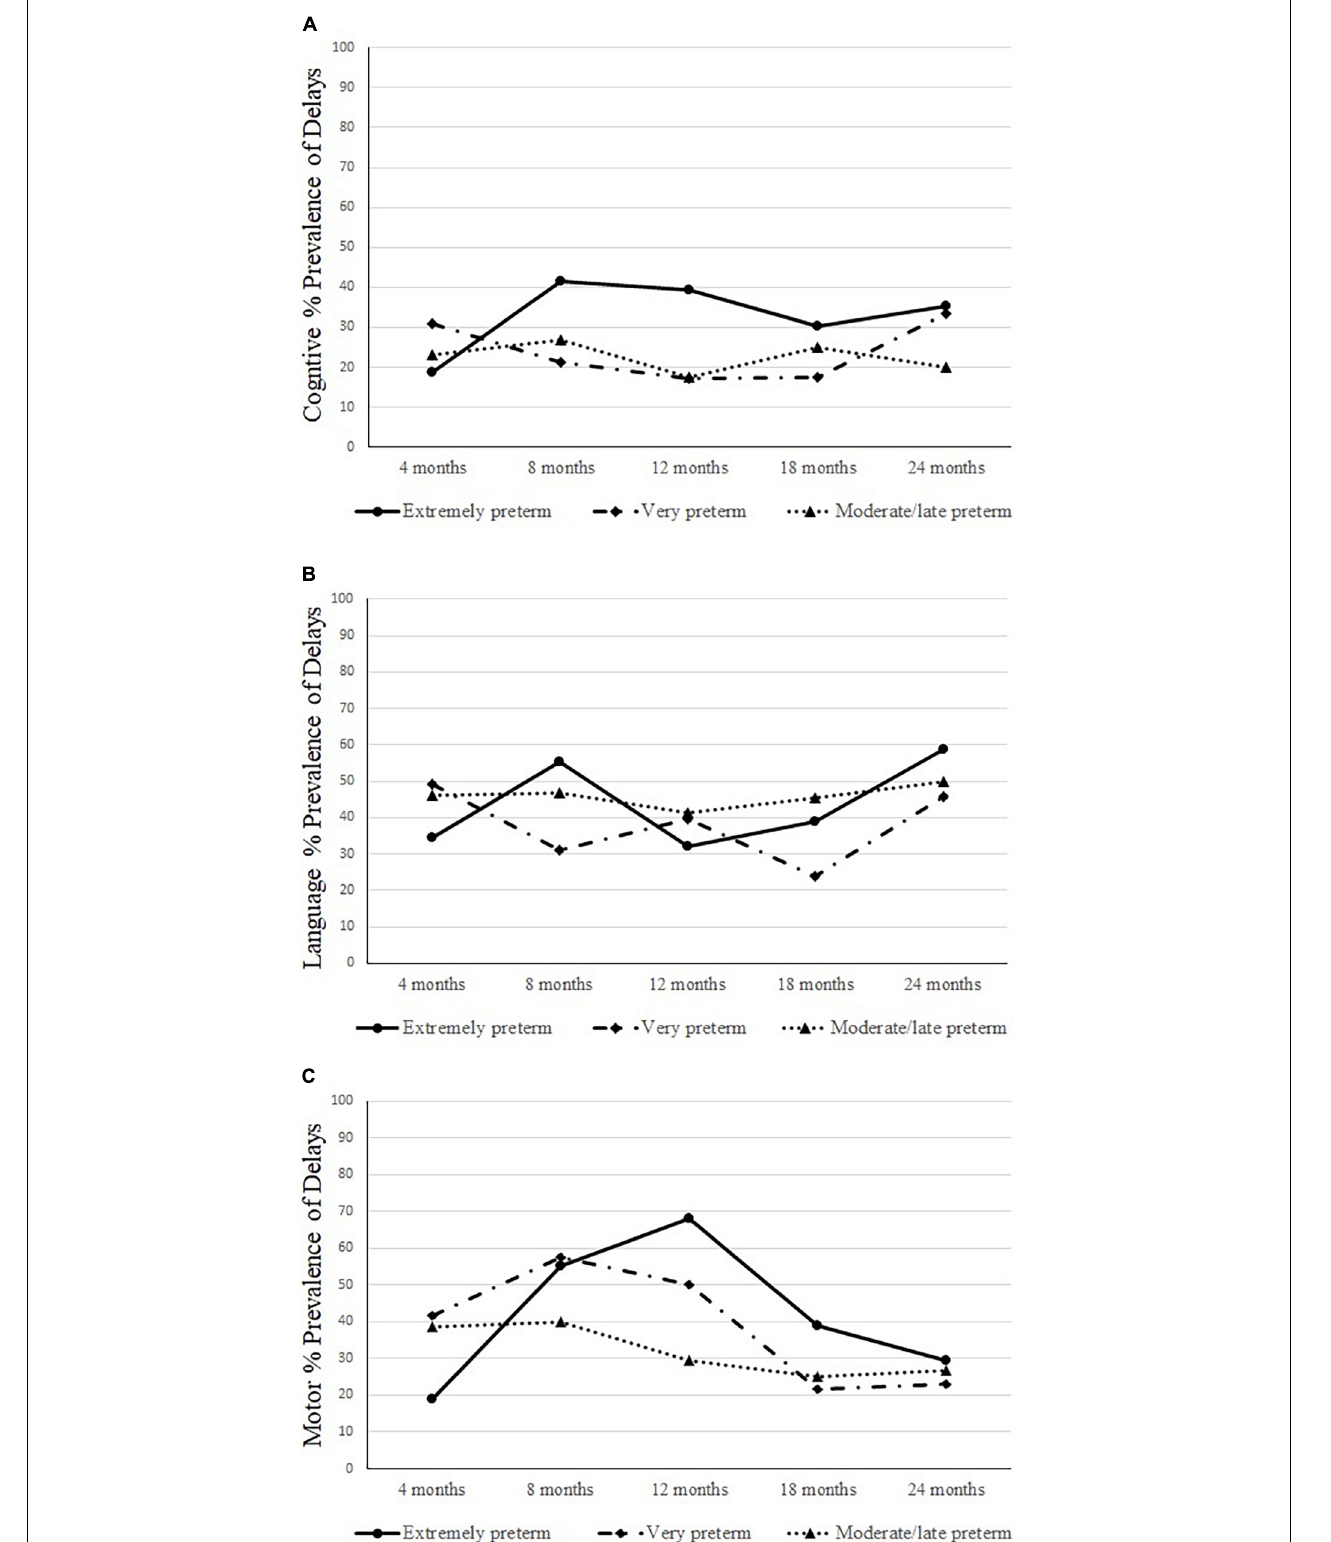
FIGURE 2 | Prevalence of cognitive (A) , language (B) , and motor (C) delays longitudinally by groups.